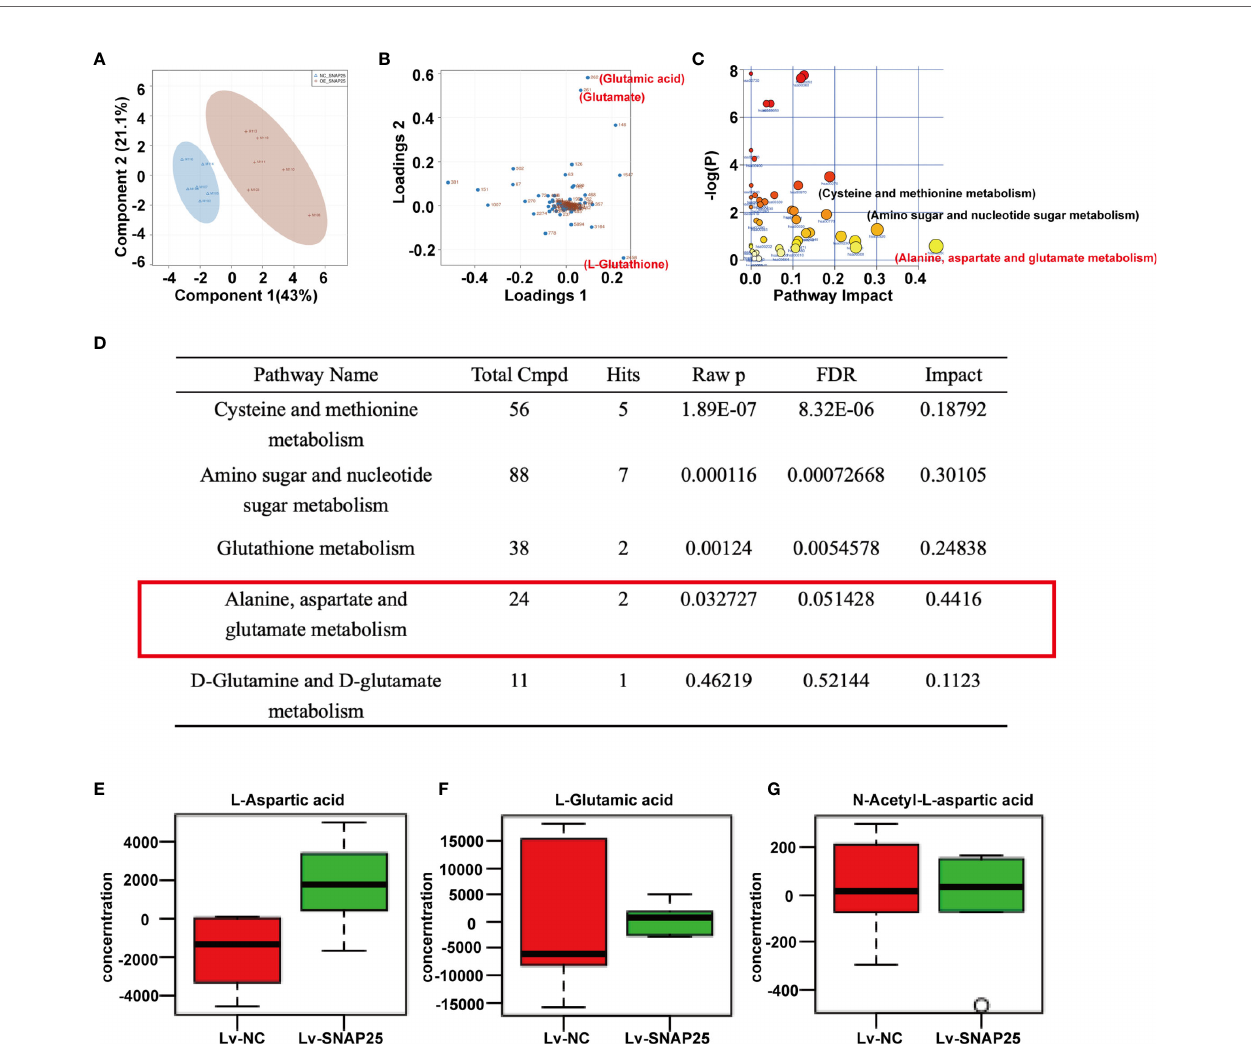
FIGURE 4 | SNAP25 regulates glutamine metabolism of glioma cells. (A) Plots of the principle component analysis results for LC-MS data obtained for Lv-NC and Lv-SNAP25 glioma cells. (B) Loading plots of the principle component analysis results for LC-MS data obtained for Lv-NC and Lv-SNAP25 glioma cells. Metabolites 261 (glutamate), 262 (glutamic acid), and 2458 (L-glutathione) contributed largely to their separation. (C, D) Pathway analysis results for LC-MS data obtained for Lv- NC and Lv-SNAP25 glioma cells. Alanine, aspartate and glutamate metabolism pathway shows a high pathway impact (0.4416), p =0.03. (E – G) The concentration of L-Aspartic acid (E) , L-Gluatamic acid (F) , and N-Acetyl-L-aspartic